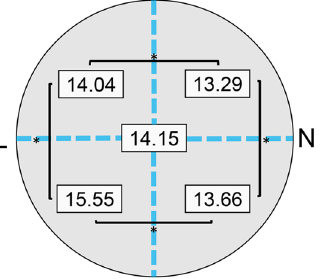
Figure 3. Location of vortex vein ampullae by sectors in all subjects. The mean distance between optic disc and vortex vein ampullae (VVA) was 14.15 mm for all eyes, and it was 14.04 mm, 15.55 mm, 13.29 mm, and 13.66 mm in the upper lateral (UL), lower lateral (LL), upper nasal (UN) and lower nasal (LN) sectors, respectively. A statistically significant difference was observed between all sectors ( P = 0.038, upper nasal sector– lower nasal sector , P = 0.000, all pairs except for upper nasal sector–lower nasal sector, Wilcoxon signed rank sum test) L lateral side, N nasal side.